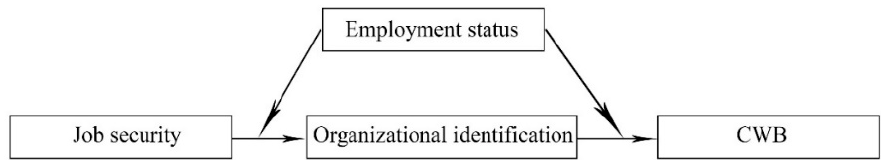
Figure 1. The hypothesized mediation and moderation model.